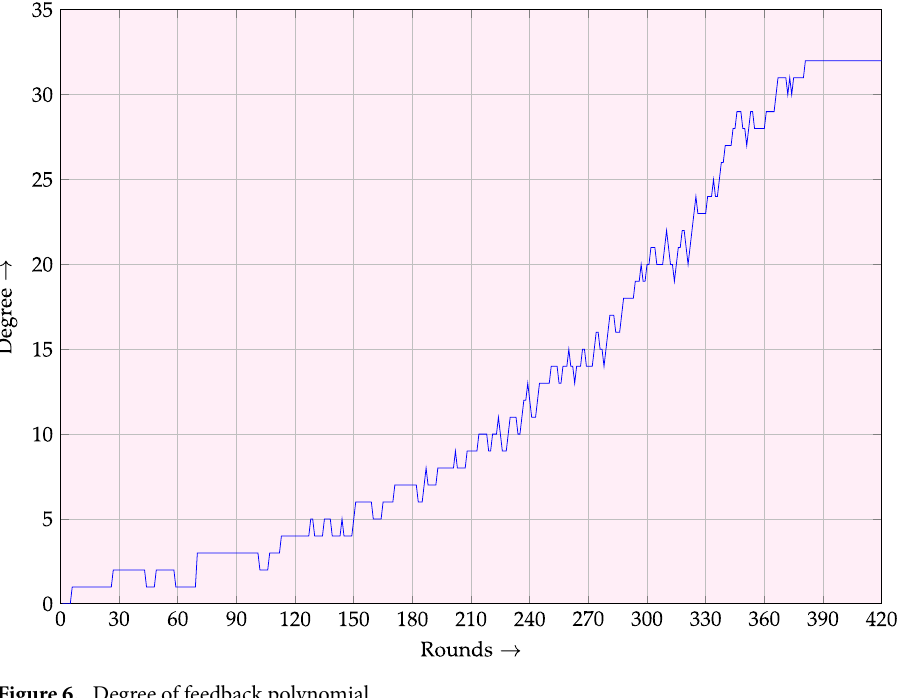
Figure 6. Degree of feedback polynomial